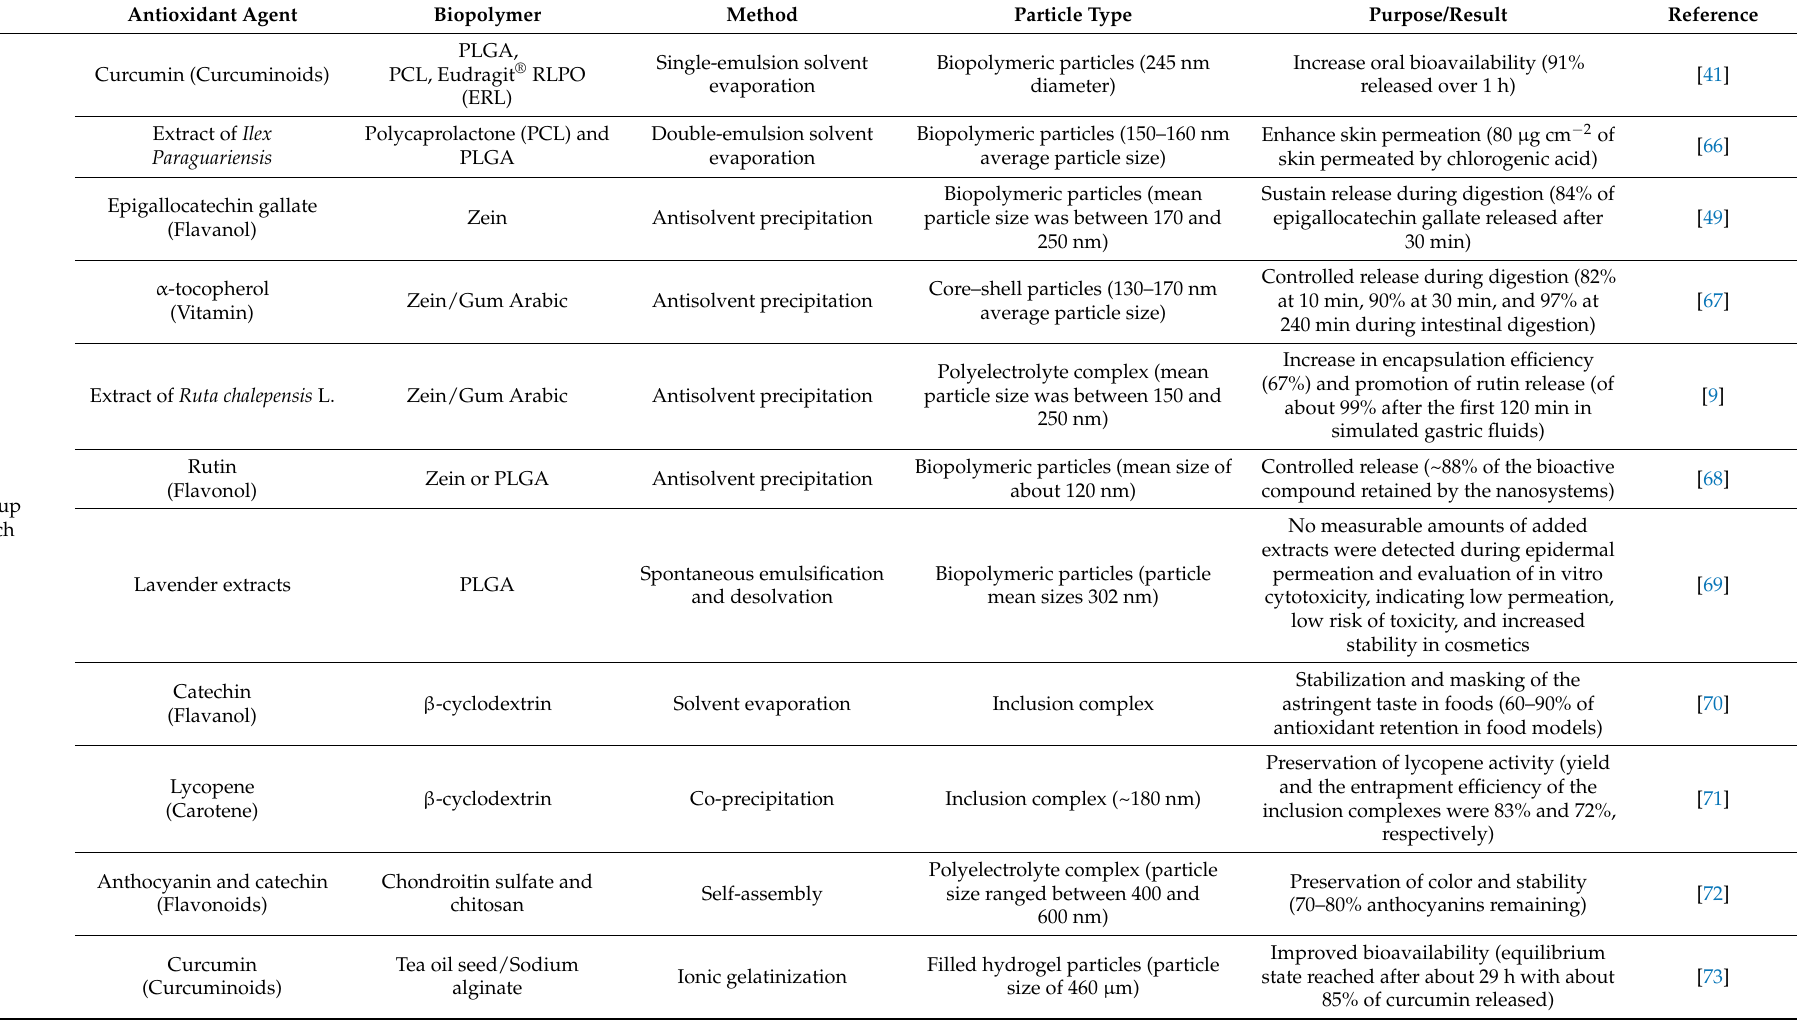
Table 1. Formulations of biopolymer-based carriers for the delivery of natural phytochemicals, with details on the preparation methods, which are classified as bottom-up or top-down; the type of particles obtained; and purpose and result of